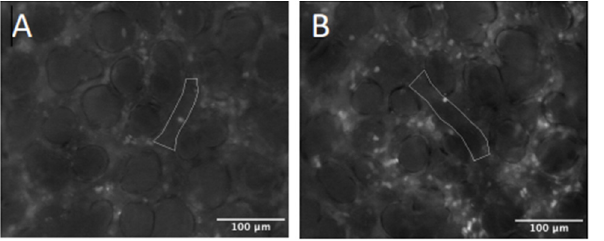
Figure 4. Intravital imaging of leukocyte adhesion in the pulmonary microcirculation. ( A ) Control group, ( B ) LPS group.